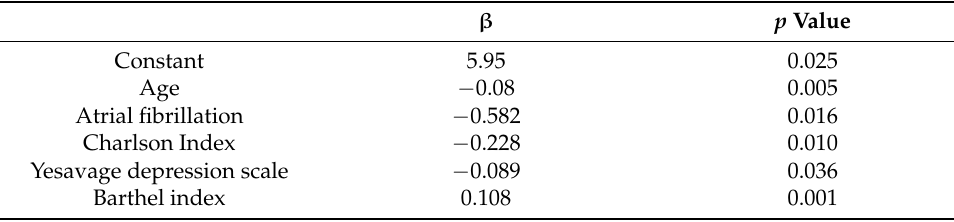
Table 3. Multivariable linear